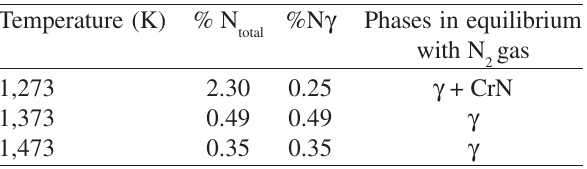
Table 2. Nitrogen absorbed, nitrogen dissolved in austenite and phases in equilibrium with N MPa.